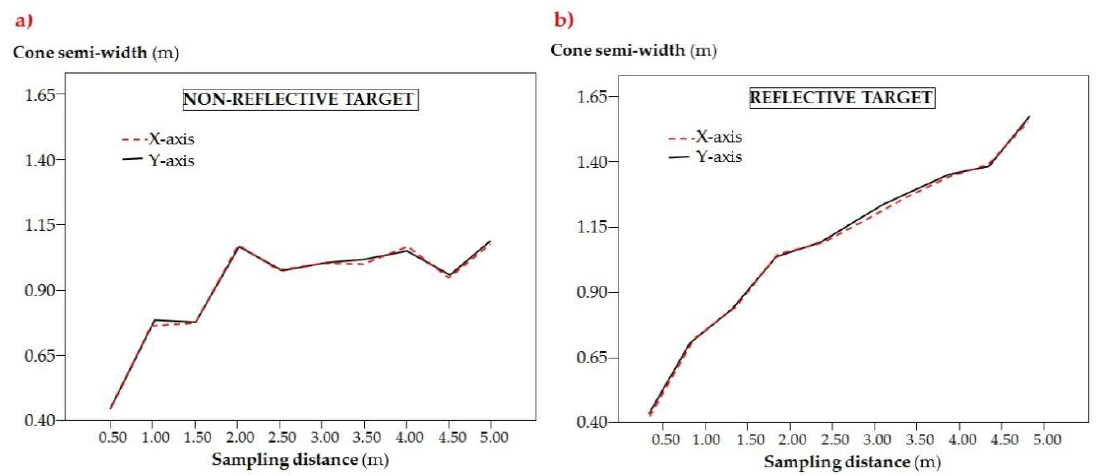
Figure 9. Cone semi width (m) for non-reflective target ( a ) and reflective target ( b ).